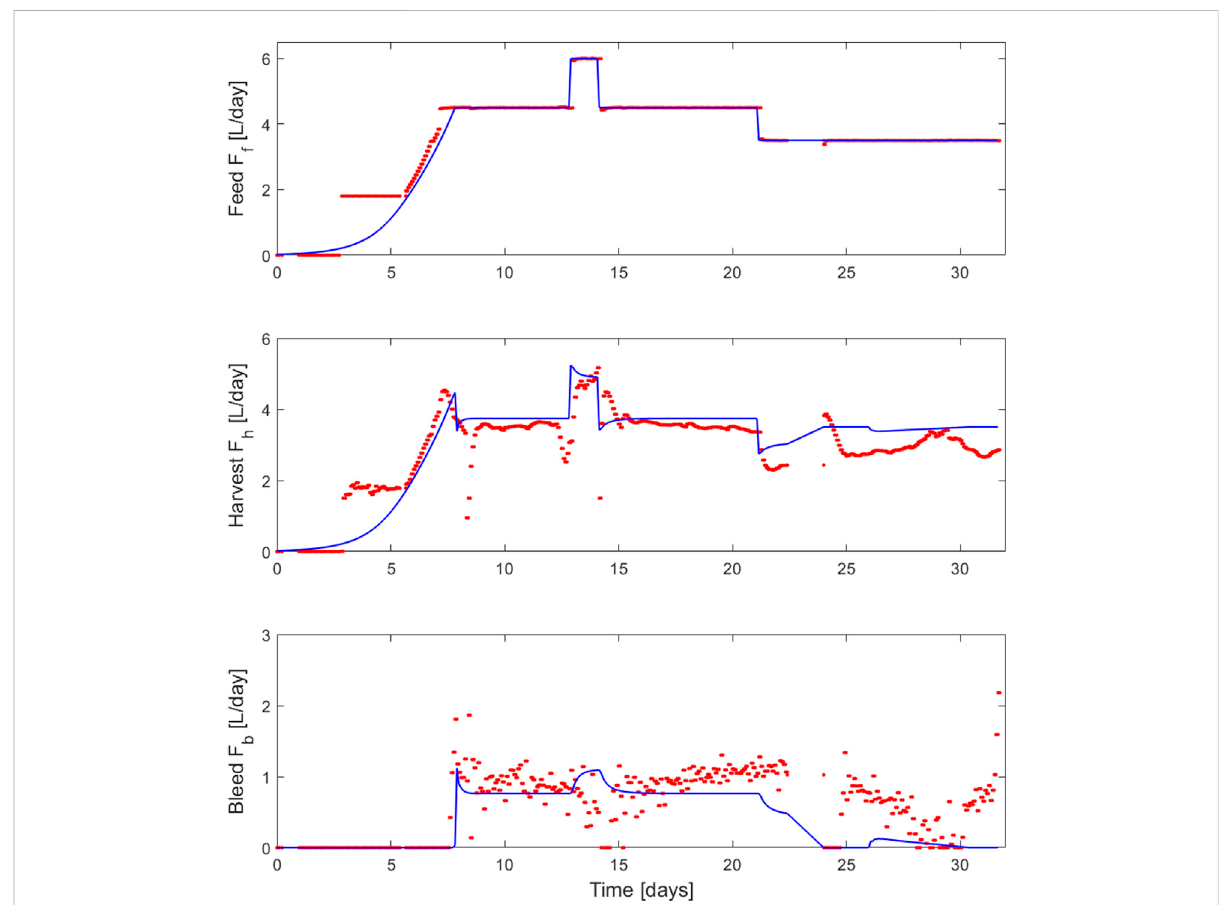
FIGURE 5 Comparison between the feed ( F h ), harvest ( F h ) and bleed ( F b ) rates implemented during 2L perfusion experiment 8 (red dots — closed loop PI control of the viable cell density measured on-line at X v , target setpoint value using F b as manipulated variable) and the model simulation